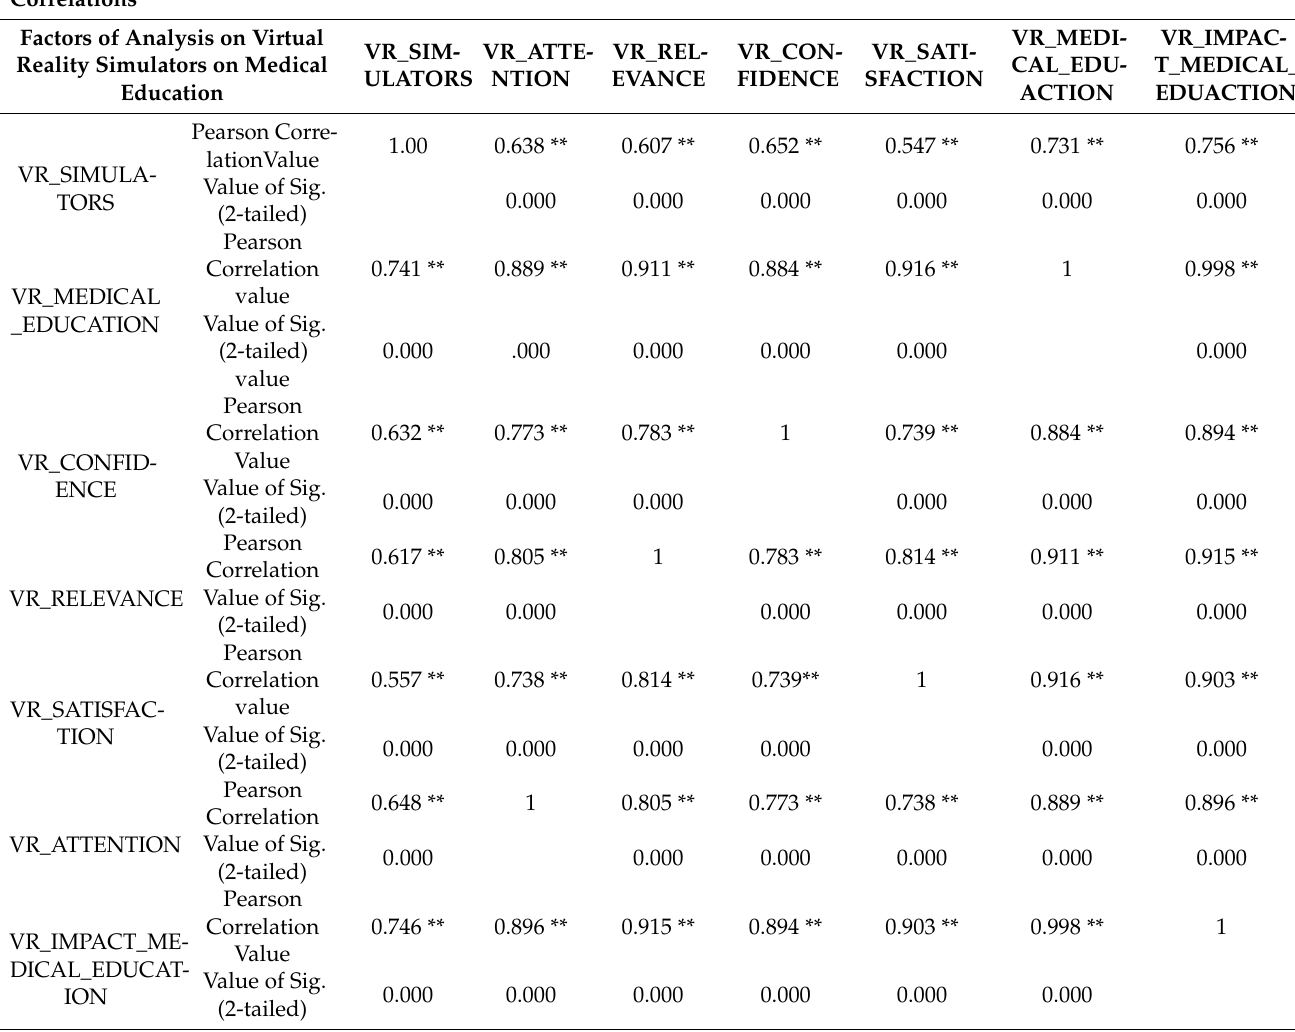
Table 3. Karl Pearson Correlation Coefficient [21] between factors of analysis on impact of a virtual reality simulators on medical education using the ARCS model of learning motivation